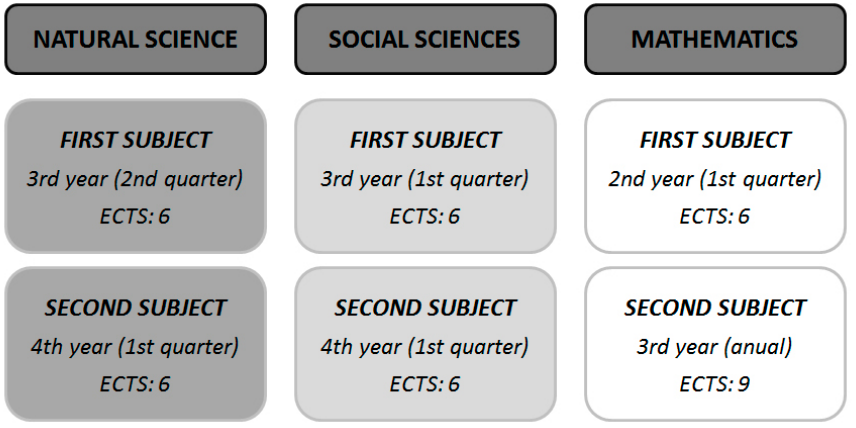
Figure 3. Compulsory subject related to the module “Learning Natural Science, Social Sciences and Mathematics” (University of Murcia).